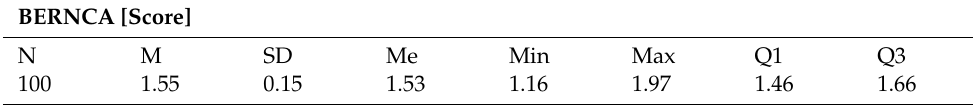
Table 2. The analysis of the BERNCA results.